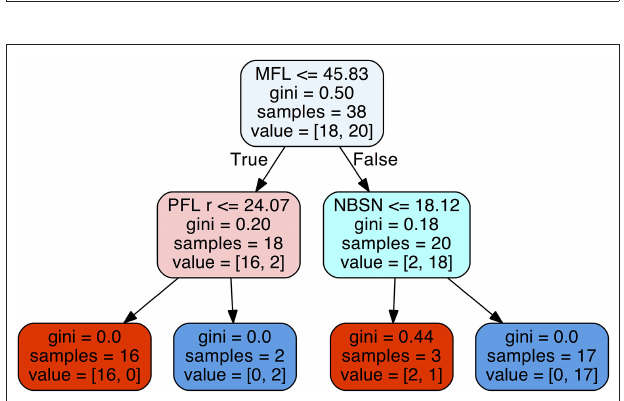
FIGURE 7 | Decision tree for the parameters midfacial length (MFL), right palpebral fissure length (PFL r), and nose breadth at sulcus nasi (NBSN).